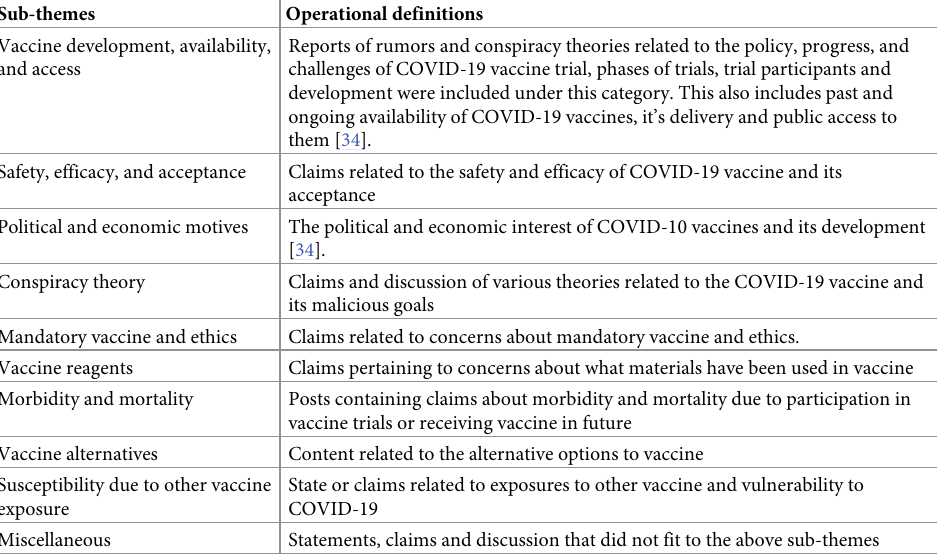
Table 1. Operational definitions of study sub-themes, 31 December 2019–30 November